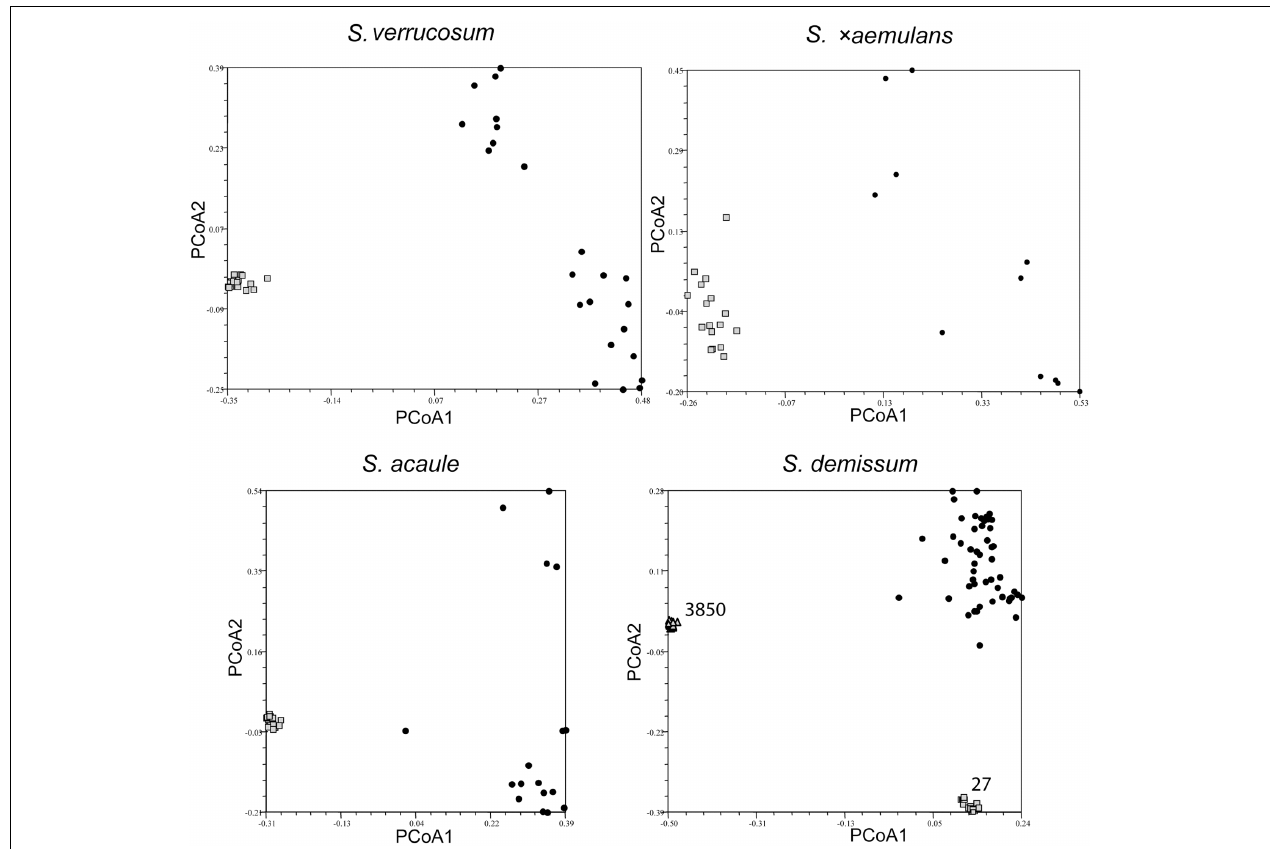
FIGURE 2 | Principal coordinate analysis showing clustering of individuals in single genebank accessions of self-compatible species Solanum verrucosum , S. acaule , S. × aemulans , S. demissum relative to a broader species sample, represented by single individuals from several genebank accessions. The relevant accessions are shown as lightly shaded (squares and triangles); the individuals representing the taxon as black